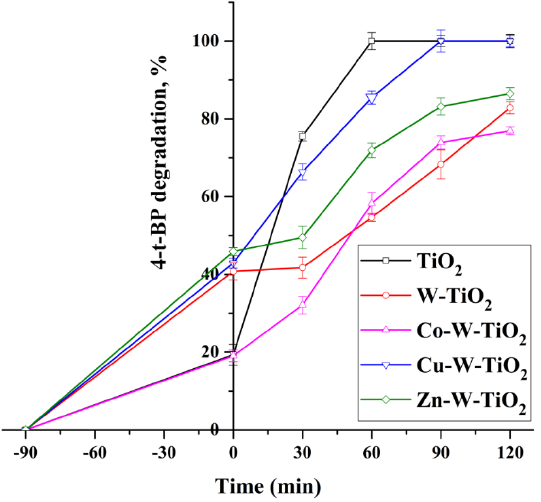
Figure 22. The photocatalytic activity of W ‐ TiO 2 , Co ‐ W ‐ TiO 2 , Cu ‐ W ‐ TiO 2 , and Zn ‐ W ‐ TiO 2 under UV irradiation. On the other hand, Cu ‐ Mo ‐ TiO 2 showed a relatively lower PL intensity than that of pure TiO 2 (Figure 23). This observation indicates a better charge separation, which could promote the photocatalytic performance of the catalyst.